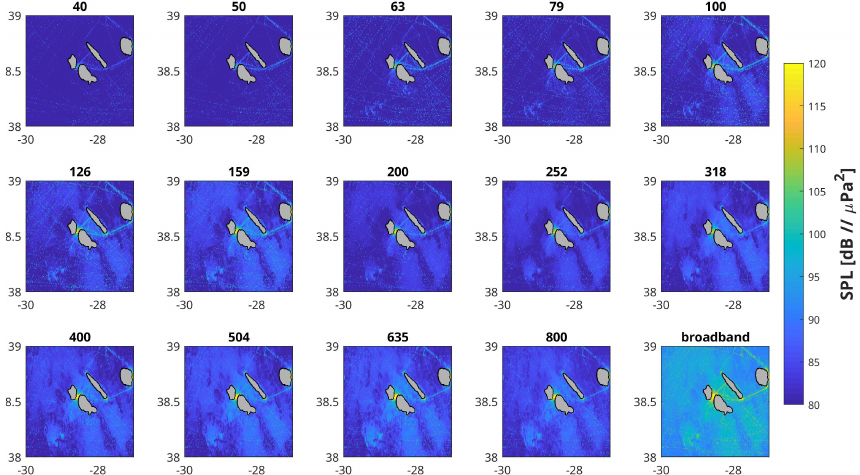
Figure 9. Estimated time mean SPL for the 1/3 octave bands (base 10) center frequencies in (40–1000)Hz and broadband mean using (10) (bottom right plot), at 10m depth for June 2018 (axes: Latitude (y), Longitude (x) both in decimal arc degrees).